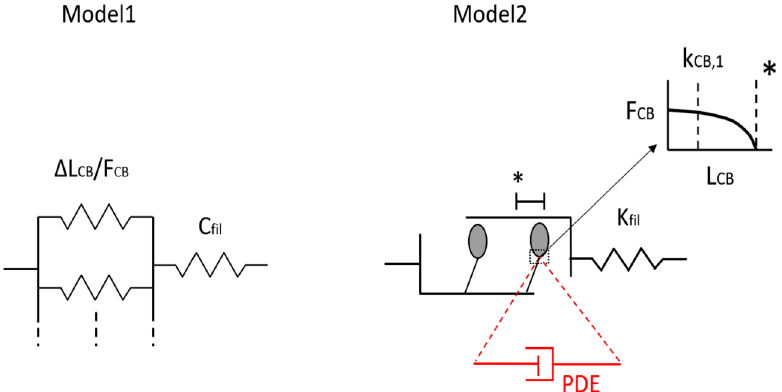
Figure 5. Elements that, according to model1 and model2 , contribute to the half-sarcomere stiffness k hs . In the elastic model1 , the myofilament compliance ( C fil ) is in series with stiffnes k CB the number of attached in-parallel myosin heads (cross-bridges, CB). The force generated by a single cross-bridge is assumed to be a constant, with an associated constant deflection ( (cid:31) L CB ). Thus, the stiffness of the ensemble of cross-bridges only F CB ( k CB (cid:31) L CB ) scales linearly with the number of attached myosin heads. In the non-linear, visco-elastic model2 , = the half-sarcomere stiffness k hs is likewise determined by the number of in-parallel attached myosin heads, with each head’s driving non-linear force–length relation F CB ( L CB ) depicted in the top right inset, and a collective of 1 k CB ( F CB ) in-series passive stiffnesses denoted myofilament stiffness ( k fil C fil ), see Eq. (8). We determined = F CB , max . See Supplementary Fig. S5 for L CB , opt = 7 nm, i.e., F CB (Eq. 7) under the assumption that L CB = = F CB ( L CB ) as determined with original model parameters. Note that, to compare model1 and model2 , we excluded the visco-elastic PDE from model2 (accordingly, PDE is marked in red). ∗ The dashed line at the asterisk marks the end of the